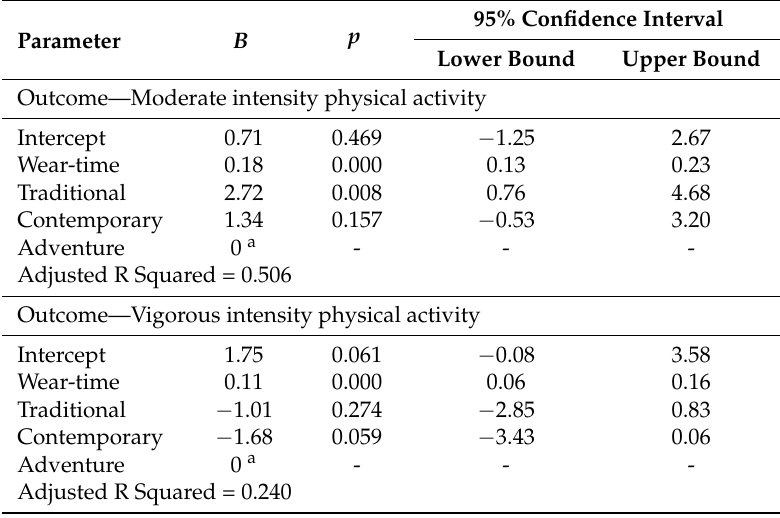
Table 2. Associations between playground type and children’s physical